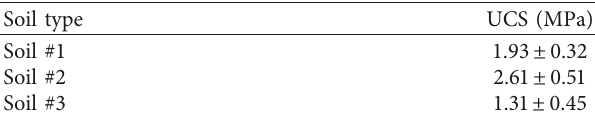
Figure 7: Soil permeability after each injection of the bacteria and cementation solution with different cementation solution concentrations. Table 3: Soil UCS after the biocement process for 3 soil types.